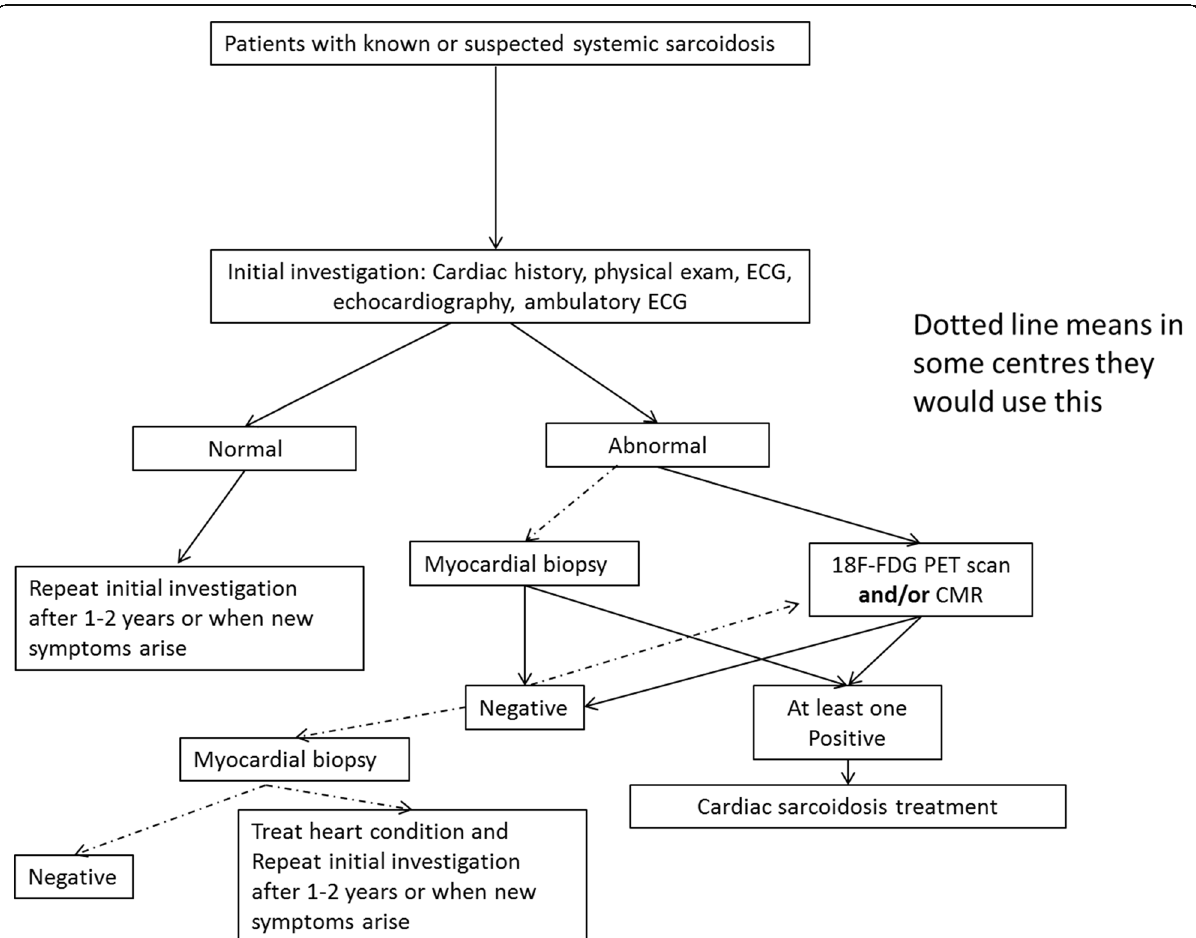
Fig. 1 Possible clinical pathway of diagnosis of cardiac